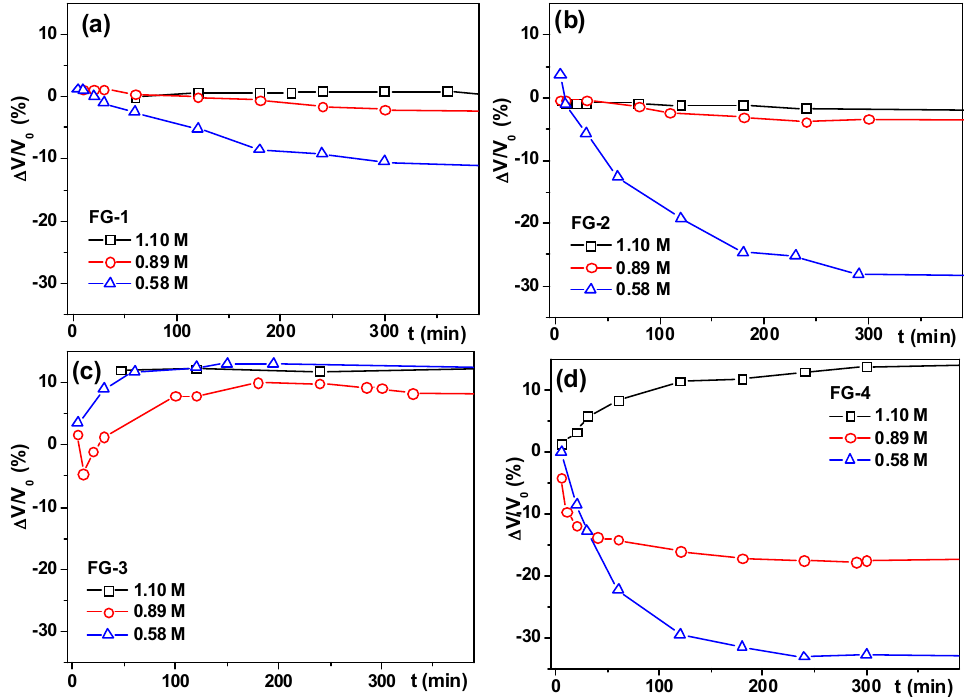
Figure 8. Time dependence of the volume deformation of ferrogels in the uniform magnetic field 0.420 T. ( a ) FG-1 series, ( b ) FG-2 series, ( c ) FG-3 series and ( d ) FG-4 series. Lines are for eye-guide only. FG-1 series filled with magnetite if the thickener was guar gum and FG-2 if the thickener was xanthan gum, filled with strontium hexaferrite FG-3 (thickener–guar gum) and FG-4 (thickener–xanthan gum). Weight fraction ranges of magnetic particles were 2.59–5.20 wt % for FG-1, 0.77–3.19 wt % for FG-2, 1.31–3.70 wt % for FG-3 and 0.77–3.33 wt % for FG-4. The legend of the plot gives the concentration of AAm in the synthesis of ferrogels, which determines the Young